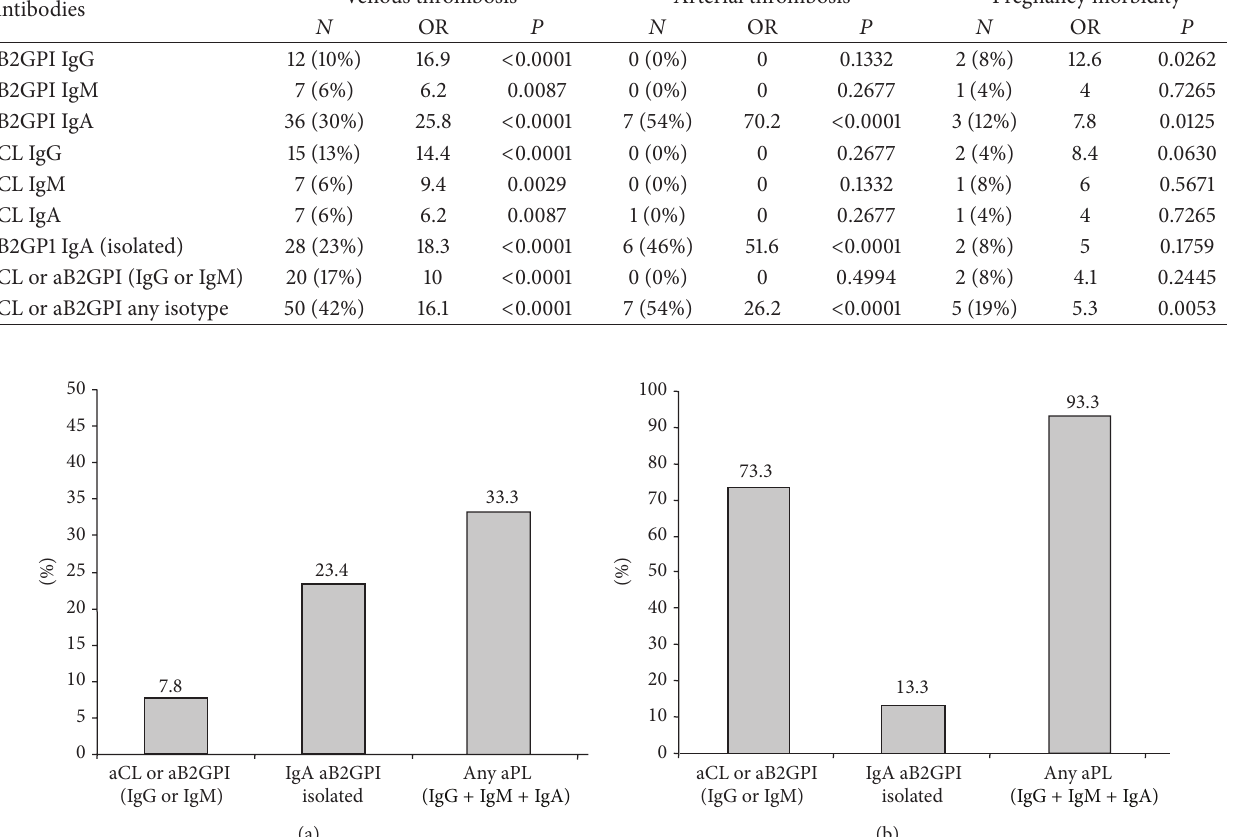
Figure 3: (a) Percentage of PAPS patients positive for aPL antibodies. (b) Percentage of SAD-APS patients positive for aPL antibodies.